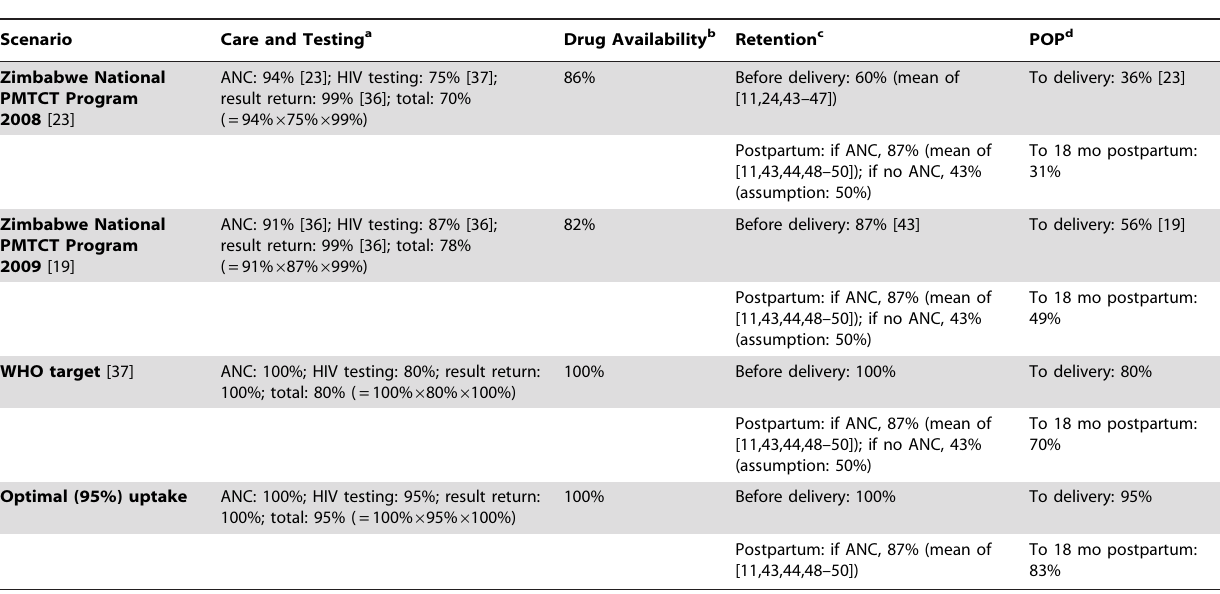
Table 1. PMTCT uptake